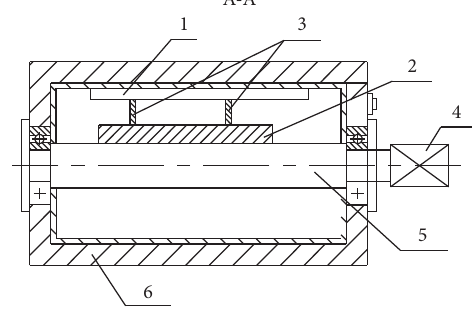
Figure 8: Sectional view of conveyor roller A-A with cathodic protection of drooping bare wires. 1, cable bridge; 2, magnesium plate; 3, hanging bare wire; 4, motor; 5, alumina ceramic conveyor roller; 6, insulation box.